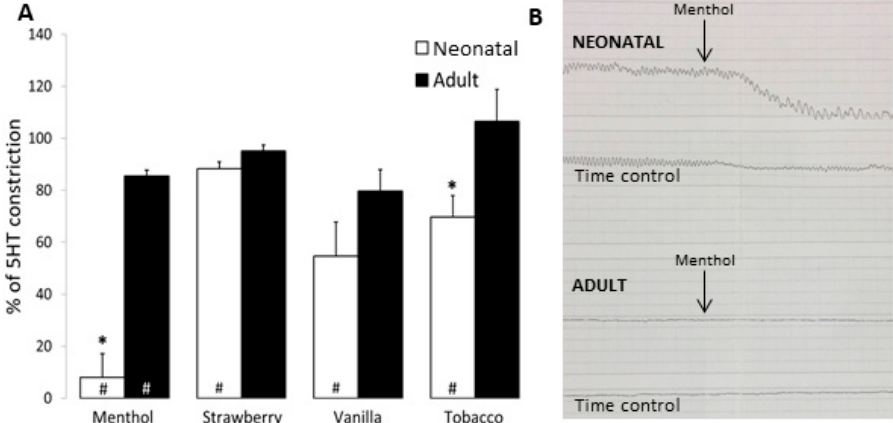
Figure 3. Flavored solutions induced greater bronchodilation in newborn as compared to adult bronchial rings. Bronchial rings (BR) isolated from neonatal and adult ovine lung were treated with flavored solutions at 1:1000 dilution. ( A ) Menthol, strawberry, vanilla, and tobacco flavorings all induced bronchodilation of neonatal BR, while only menthol induced bronchodilation in adults (# p < 0.05 as compared to time control). Neonatal airway demonstrated significant decrease as compared to adult with both menthol and tobacco exposure (* p < 0.05 as compared to adult). Data are presented as mean + SEM. n = 3–8. ( B ) Representative tracing demonstrating neonatal and adult responses in BR treated with menthol flavoring (top) as compared to untreated (time control).